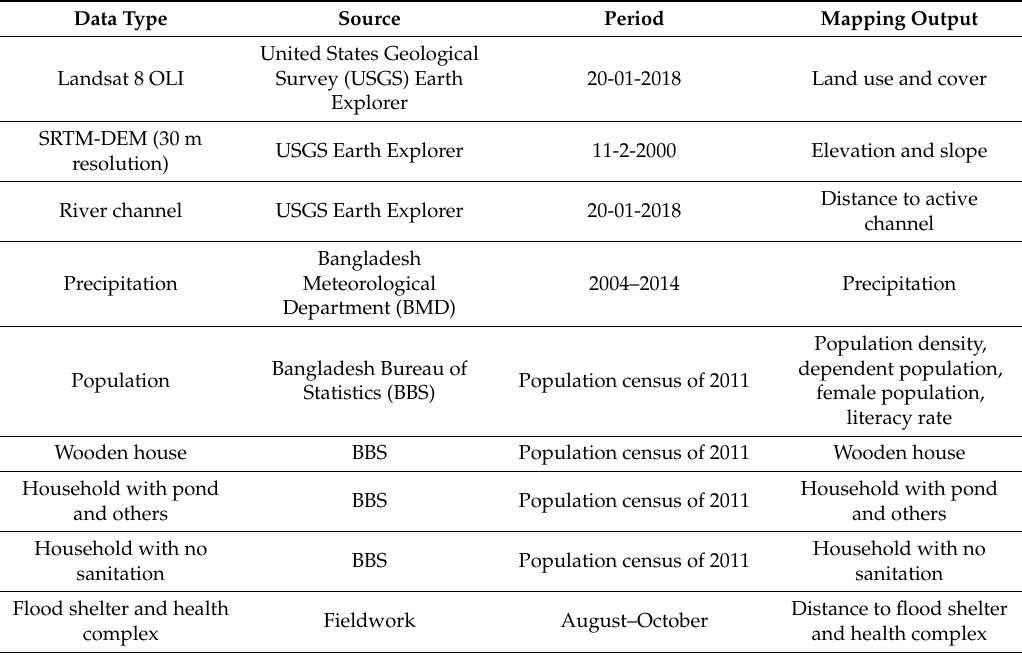
Table 1. Data type and sources used in this